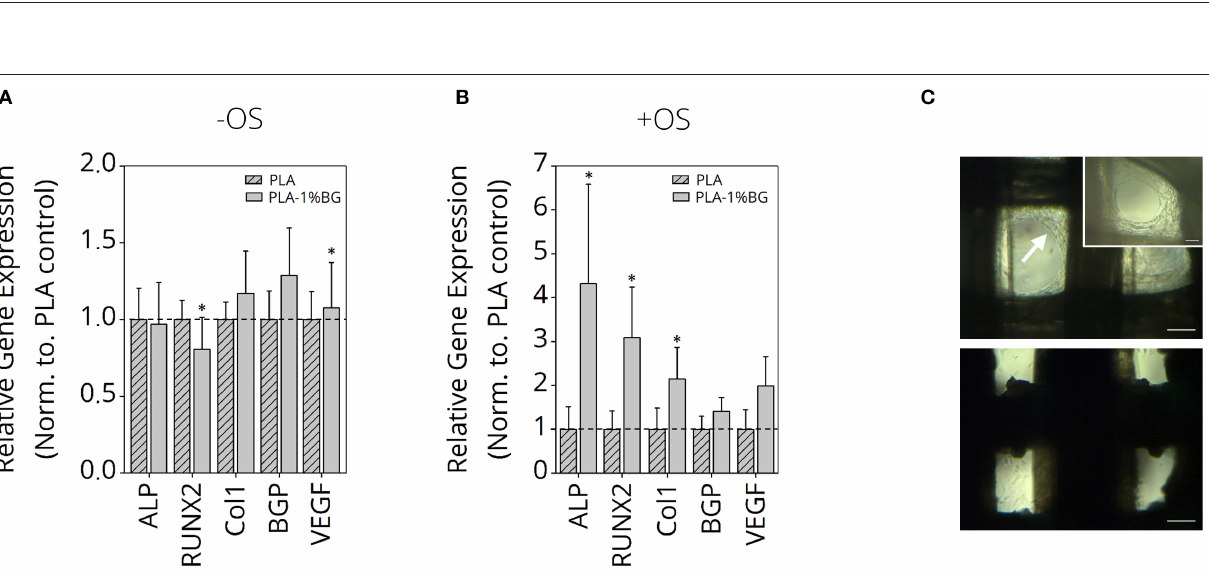
Frontiers in Bioengineering and Biotechnology | www.frontiersin.org